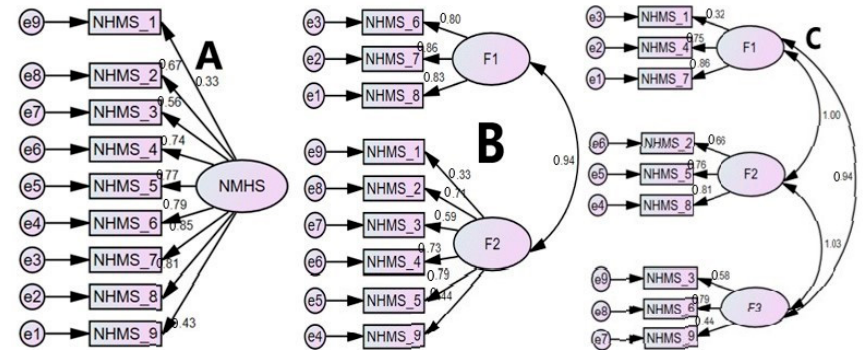
Figure 2. Confirmatory factor analysis models of the Athens Insomnia Scale (AIS) scores in Indian computer professionals. A: 1-Factor (Soltatos et al.; Gomex-Benito et al.), B: 2-Factor model (Chung et al.; Yen et al.), C: 2-Factor (Okajima et al.) and D: 3-Factor model (EFA finding in this study). All coe ffi cients are standardized. Ovals latent variables, rectangles measured variables, circles error terms, single-headed arrows between ovals and rectangles factor loadings, single-headed arrows between circles and rectangles error Table 5. Fit statistics of the Athens Insomnia Scale (AIS) scores in Indian computer professionals.